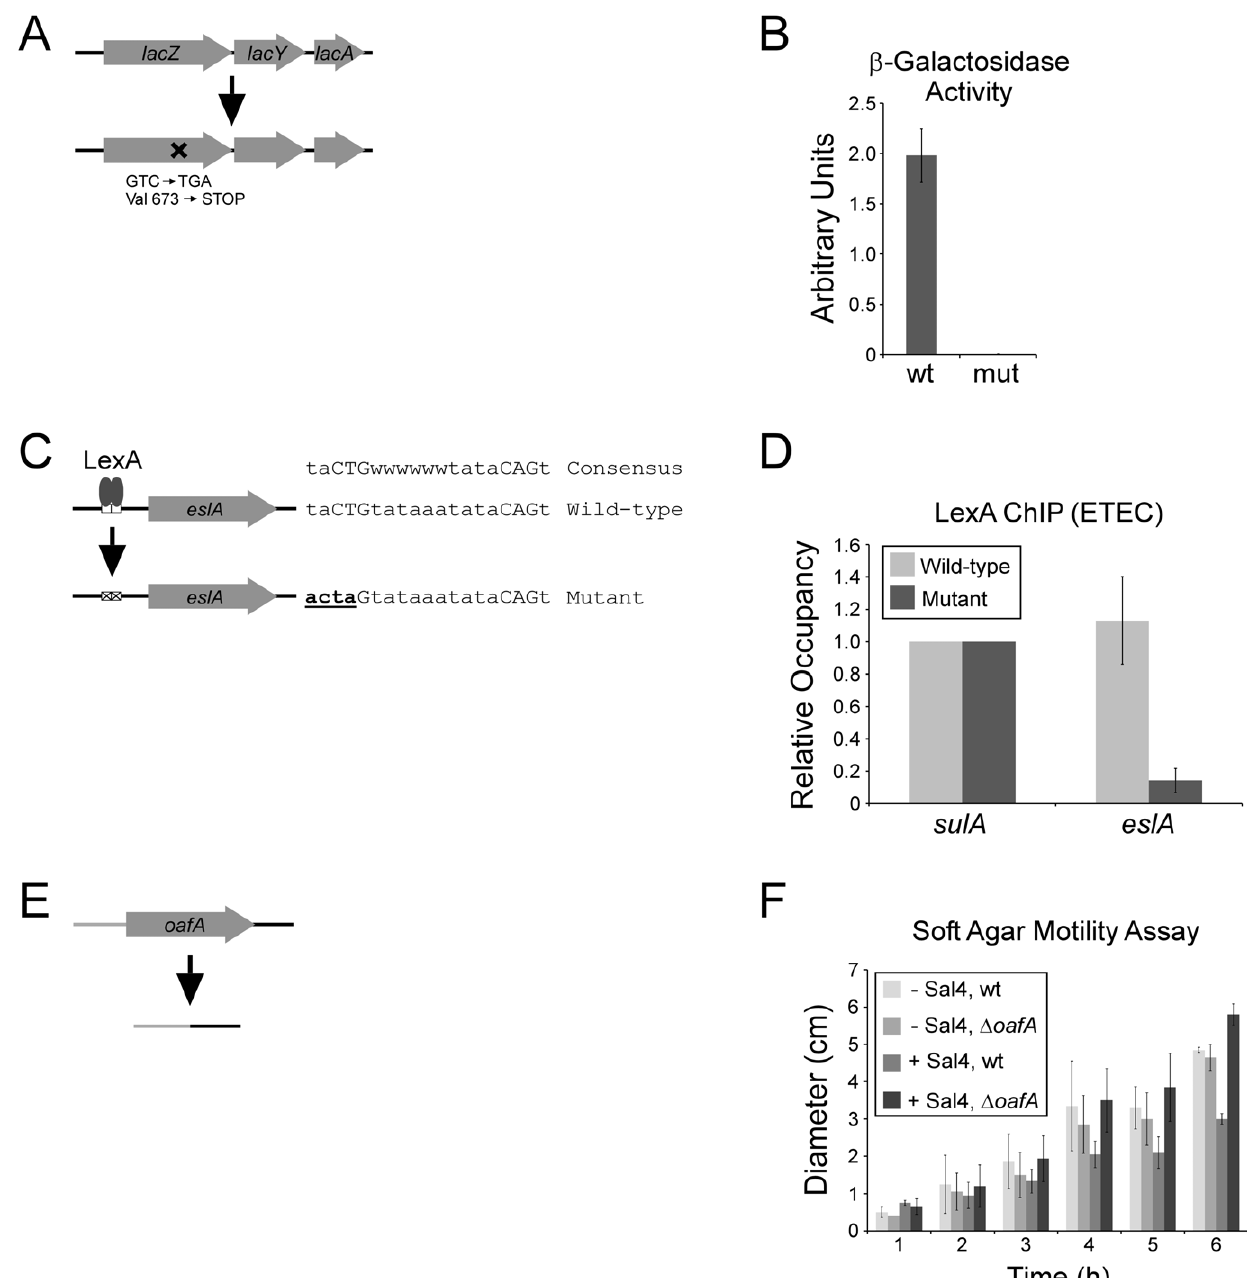
Figure 1. Schematic of FRUIT method. (A) Schematic of FRUIT for introducing point mutations or deletions. PCR product is amplified from the recombineering template plasmid (pAMD001), incorporating flanking sequence with identity to the desired site of recombination. This PCR product is introduced into cells expressing l recombinase proteins and recombinants are selected using the thyA marker (growth on media lacking thymine). A mutation can then be introduced by recombineering a second PCR product, selecting for recombinants using counter-selection of thyA (growth in the presence of trimethoprim). (B) Schematic of FRUIT for introducing FLAG tags. As above, except that loss of thyA occurs spontaneously due to homologous recombination of duplicate sets of FLAG tags.